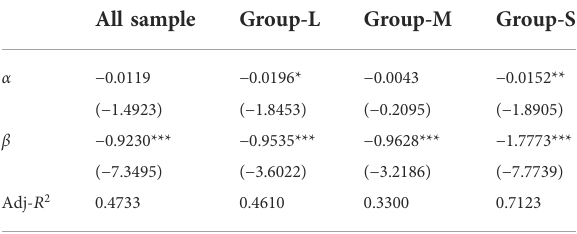
TABLE 3 Test for β -convergence of energy